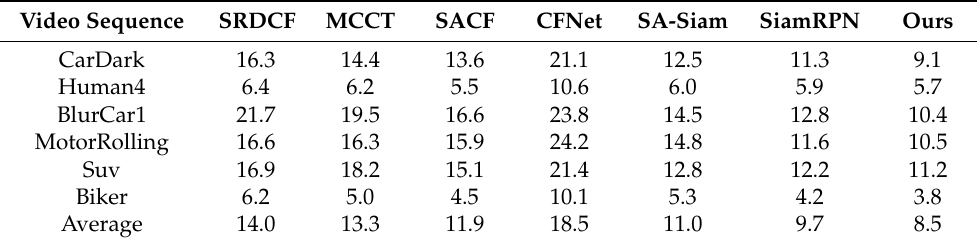
Table 4. The average CLE (pixels) of the various object tracking algorithms in the testing sequences. Video Sequence